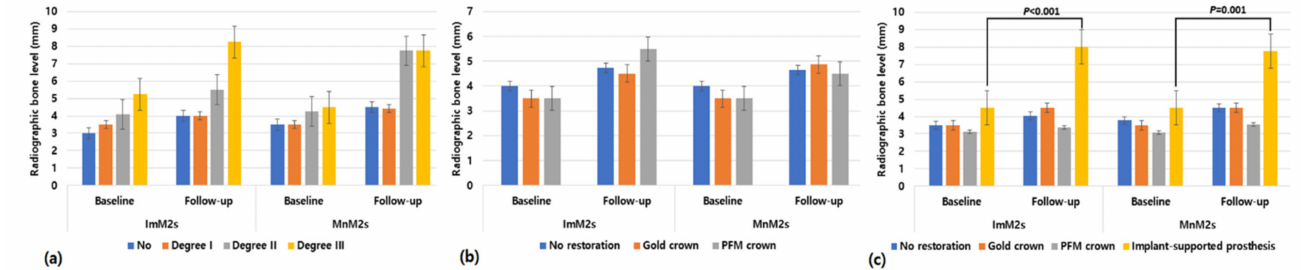
Figure 4. Changes in radiographic bone levels of the mandibular first molars (MnM1s) between baseline and the last follow-up according to ( a ) furcation involvement of MnM1s, ( b ) prosthetic type of MnM1s, and ( c ) prosthetic type of antagonists. Abbreviations: ImM2s, implants placed in the mandibular second molar site; MnM2s, the mandibular second molars; PFM, porcelain fused metal